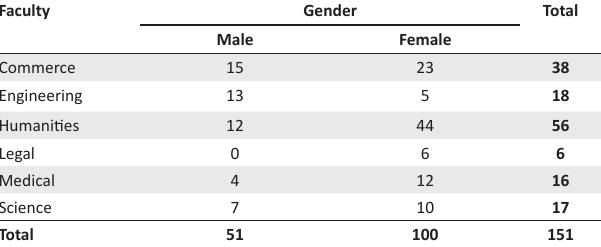
TABLE 1: Cross-tabulation of faculty and